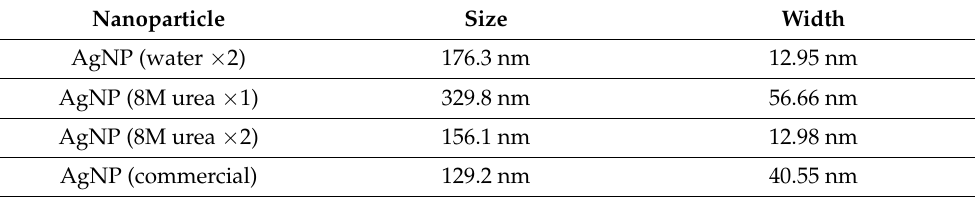
AgNP (commercial) ThermoFisher latex particle control (61 nm ± 4) = 65.2